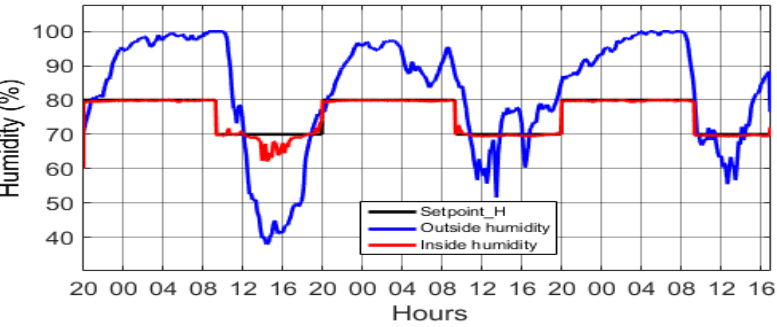
Figure 16. The variation in the relative humidity with the FLC controller.